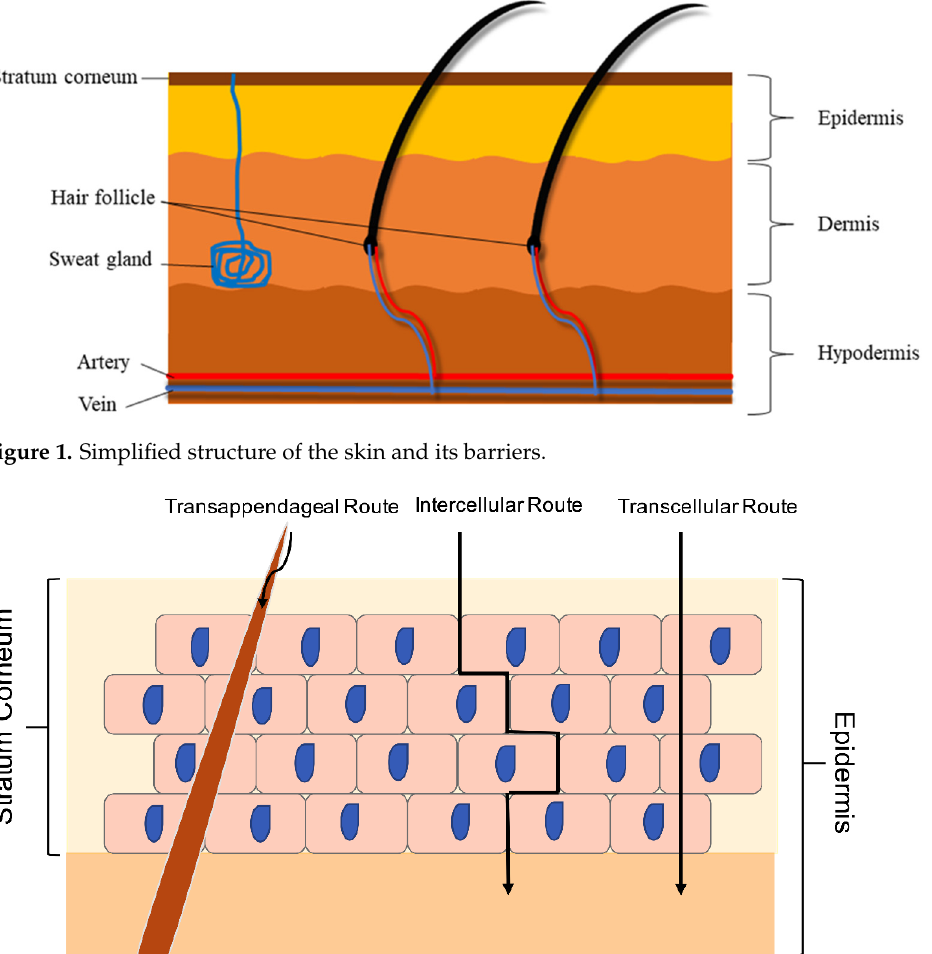
Figure 1. Simplified structure of the skin and its barriers.